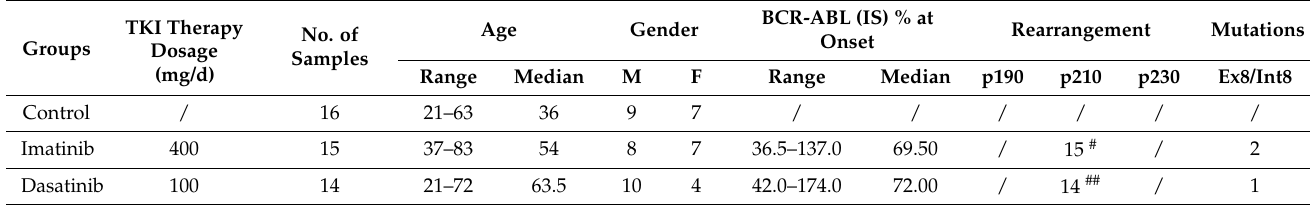
Table 1. Baseline characteristics of healthy subjects and CML